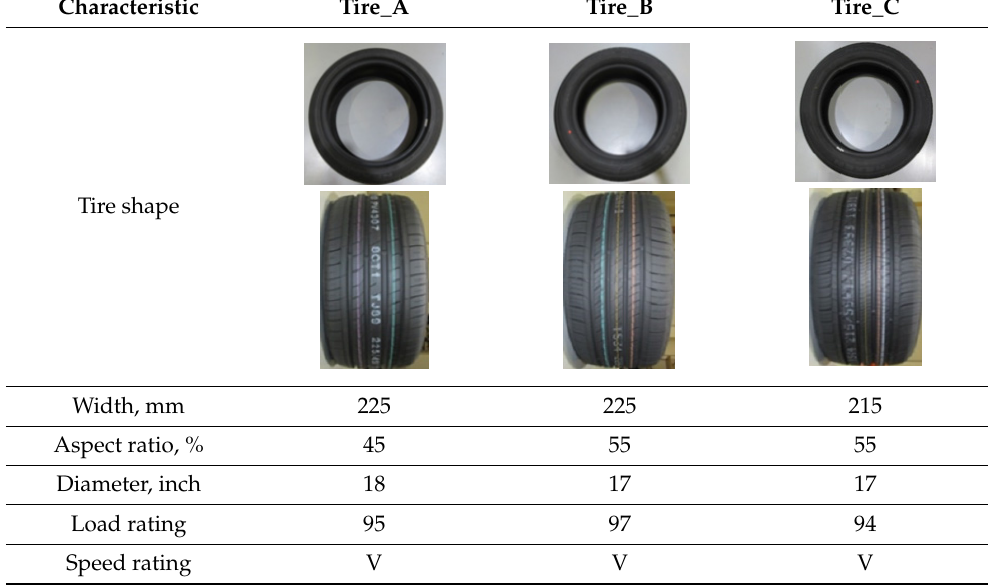
Table 3. Tire component classification.